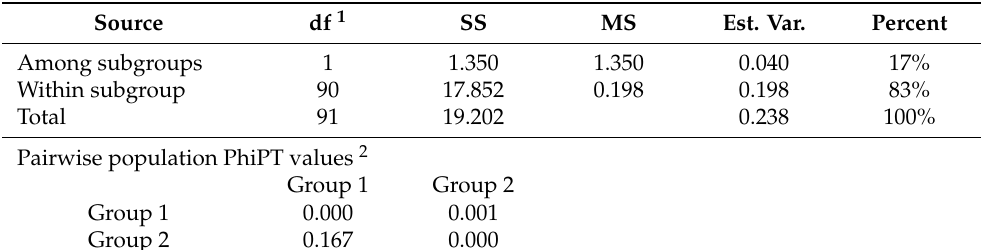
Table 1. Summary of AMOVA and pairwise comparison using PhiPT values among and within subgroups. Source df 1